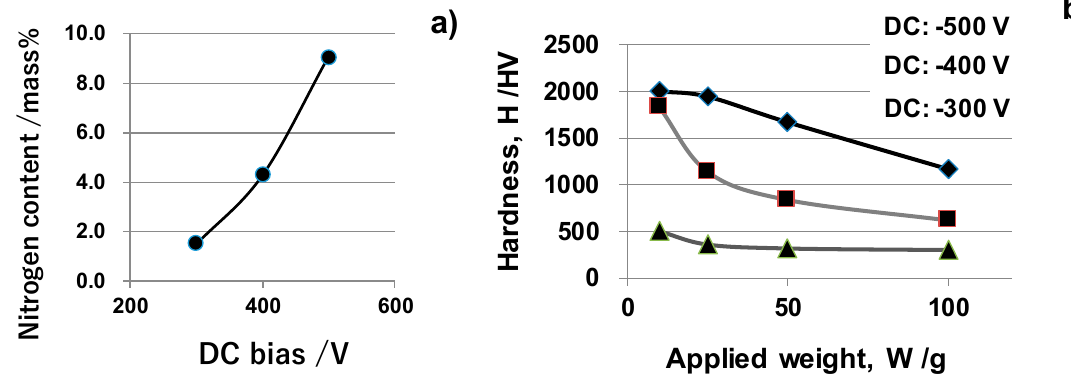
Figure 3. Effect of DC-bias on the nitrogen content and hardness. ( a ) Variation of the nitrogen solute content, and, ( b ) variation of hardness profile.